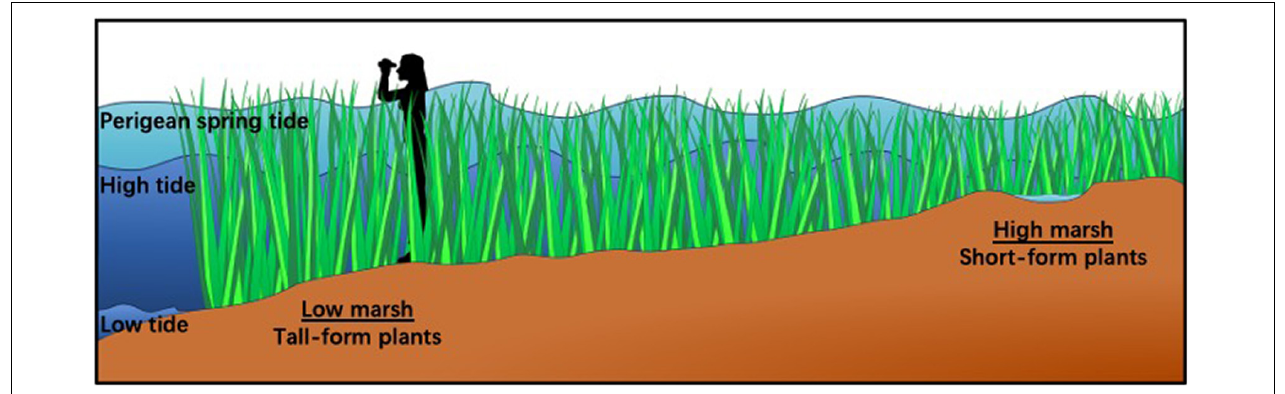
FIGURE 1 | Trait variation in Spartina alterniflora is correlated with tidal inundation across the marsh. Tall-form plants ( > 2 m) grow adjacent to tidal creeks in the low marsh where they are inundated daily. Plants decrease in height across increasing elevation such that short-form plants ( < 0.25 m) are found in the high marsh where exposure to tidal flooding is less often and for less duration. Perigean spring tides are extremely high tides often referred to as “King Tides” which reach the highest elevation in the marsh. They happen 6–8 times a year and inundate the entire salt marsh community (see: https://oceanservice.noaa.gov/facts/perigean-spring-tide.